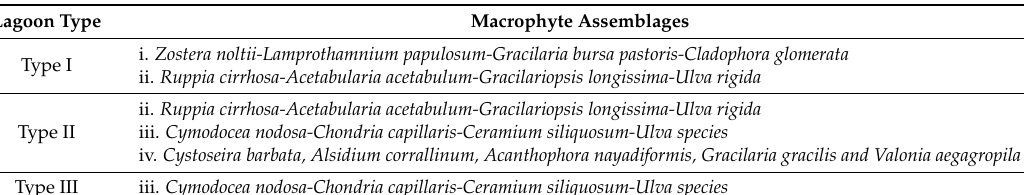
Figure 4. Species ordination obtained by the detrended correspondence analysis (DCA) conducted with species coverages data (%) in the three different lagoon types of Western Greece. Table 2. List of the species belonging to the four macrophyte assemblages (i–iv) identified after the detrended correspondenceaAnalysis (DCA) in the three lagoon types of Western Greece.